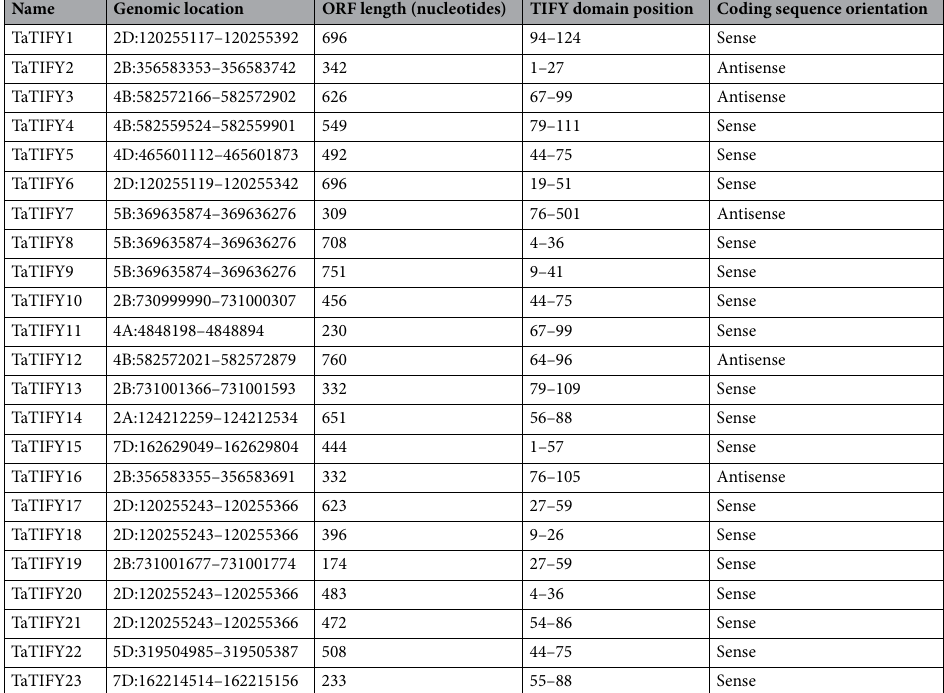
Table 1. Novel TaTIFY genes identified in wheat, their genomic location, ORF lengths, TIFY domain positions and orientation of coding sequences.